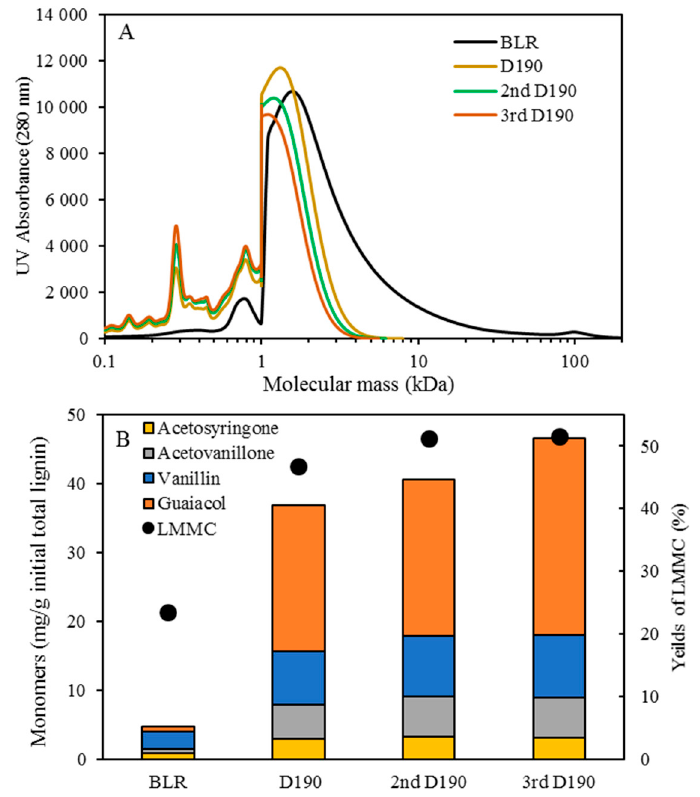
Figure 5. Characterization of BLR with 1-3 rounds of repeating depolymerization in 190 °C. ( A ) Molecular weight distributions of BLR and the first, second, and third depolymerized BLR products, measured as UV absorbance at 280 nm. ( B ) The yields of lignin LMMC and concentration of lignin monomers in LMMC before and after depolymerization of 1–3 rounds.